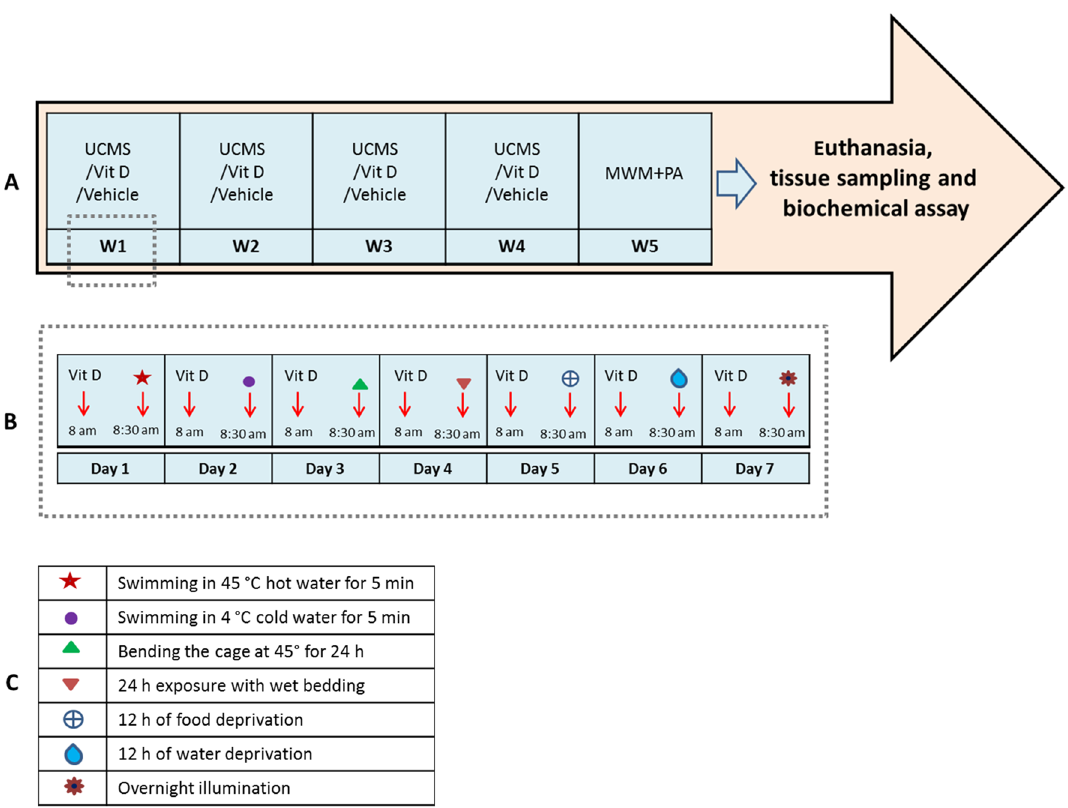
Figure 12. Schematic timeline indicating the sequence of experimental protocol. ( A ) Application of UCMS/Vit D administration followed by behavioral and biochemical assessments during 4 weeks, ( B ) Timing and pattern of Vit D/UCMS application during one week and ( C ) various types of stressors used in this